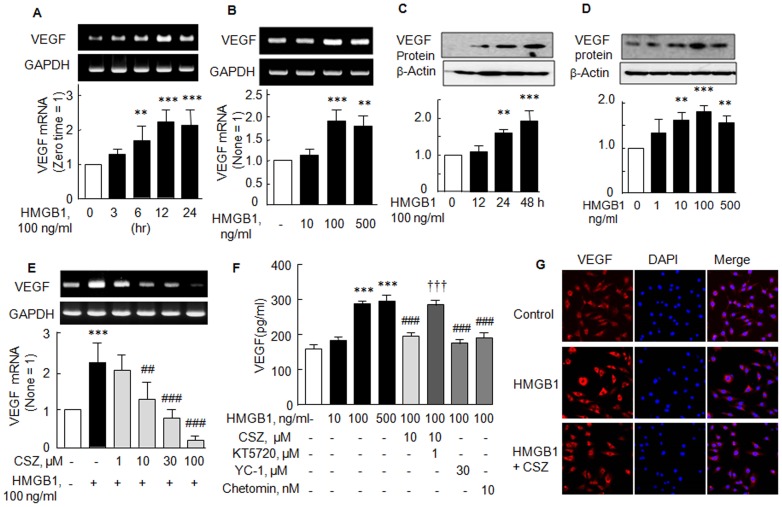
Suppression of HMGB1-induced elevations of VEGF mRNA and protein expressions by cilostazol.(A, B, C and D) Time- and concentration-dependent increases in VEGF mRNA and protein expressions stimulated by HMGB1. (E) Concentration-dependent suppression of HMGB1-stimulated VEGF mRNA expression by cilostazol (1–100 µM). (F) HMGB1-induced increase in VEGF releases and the attenuation of VEGF release by 10 µM cilostazol, by 30 µM YC-1 (HIF-1α inhibitor), and by 10 nM chetomin. The effect of cilostazol was blocked by KT5720 (KT, 1 µM) pretreatment. (G) Representative immunofluorescence photographs showing greater VEGF (+)-staining in HMGB1-treated synovial fibroblasts (24 hr), compared with control synovial fibroblasts. After treatment with cilostazol (10 µM), VEGF (+)-staining was obviously reduced. Results are expressed as means ±SEM of 4–5 experiments. **P<0.01, ***P<0.001 vs. no treatment; ##
P<0.01, ###
P<0.001 vs. 100 ng/ml HMGB1 alone; †††
P<0.001 vs. 10 µM cilostazol.